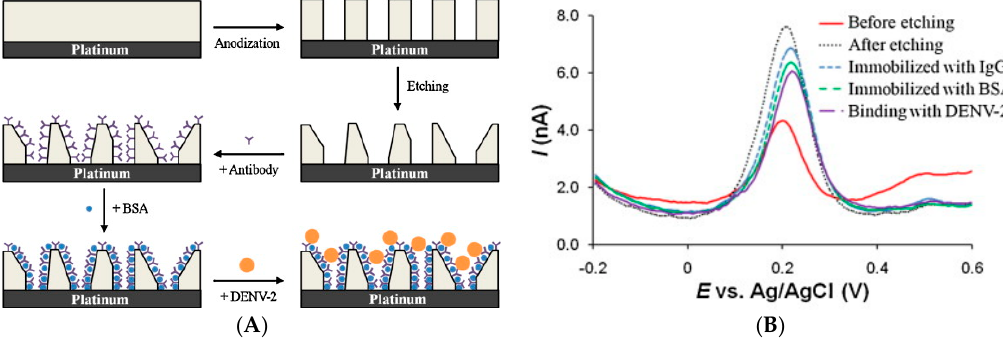
Figure 36. ( A ) Biosensor’s structure and detection procedure. DENV-2 corresponds to the dengue virus; ( B ) Differential pulse voltammograms of alumina-modified electrode obtained in 1.0 mM ferrocenemethanol, 0.1 M phosphate buffered saline, pH 7.4 after each step of the biosensor construction procedure, DENV-2 concentration = 10 2 pfu mL − 1 ; Adapted from [186], Copyright 2012, with permission from Elsevier.